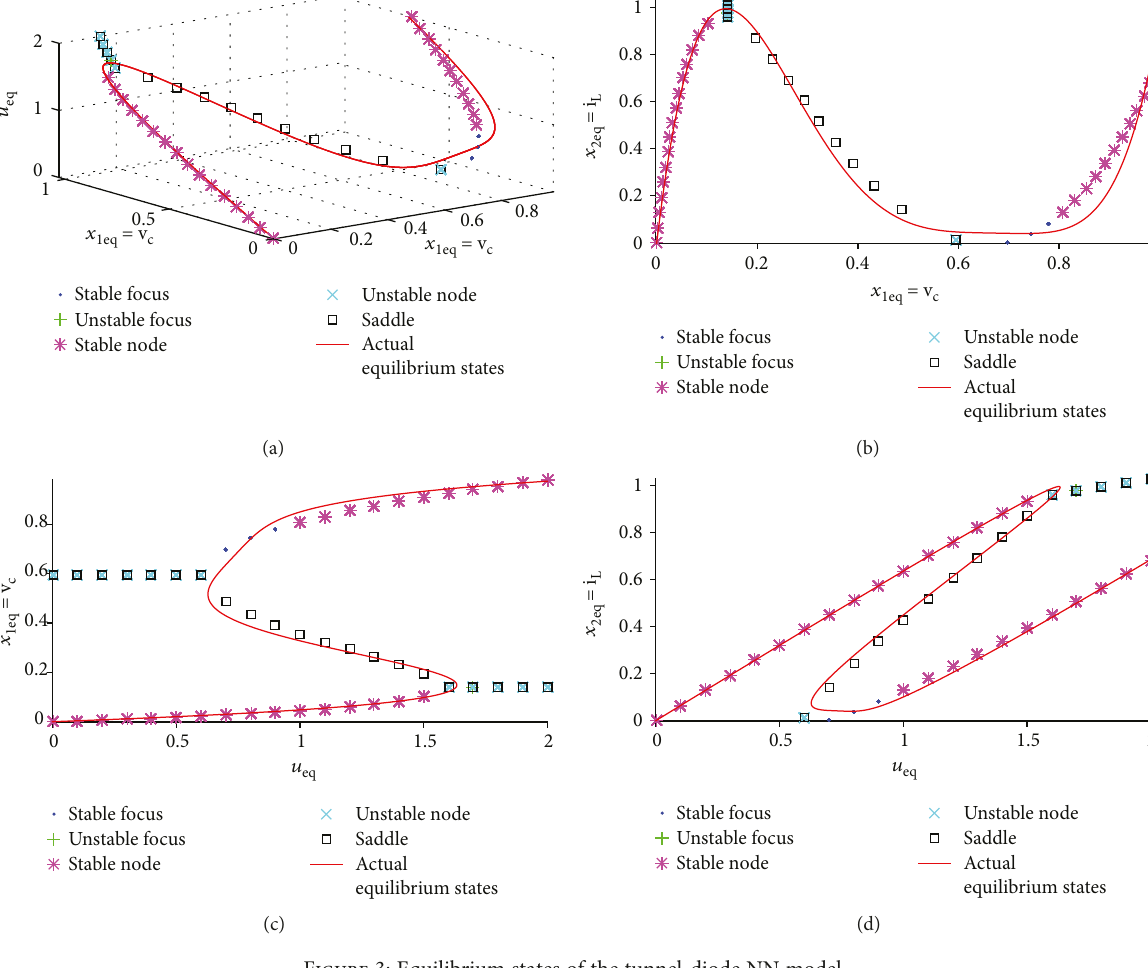
Figure 3: Equilibrium states of the tunnel-diode NN model.